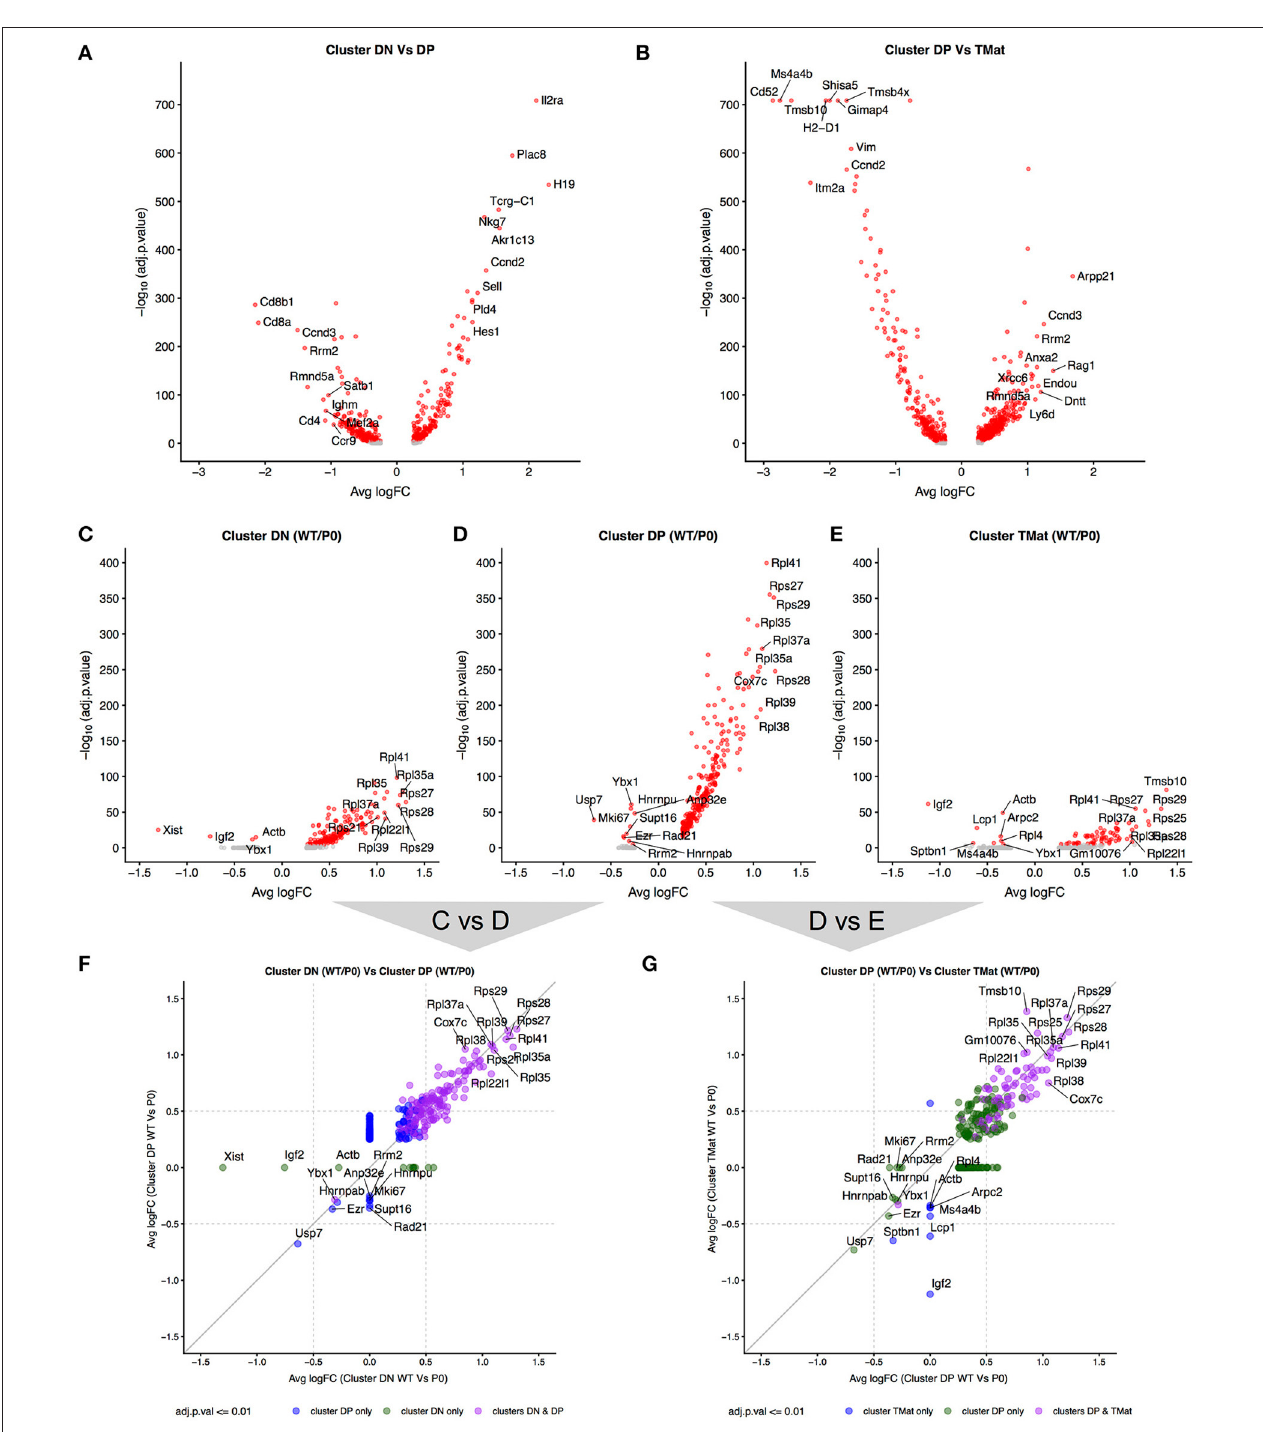
FIGURE 7 | Differential transcript levels between identified cell type clusters and within cluster WT/P 0 differences. (A,B) Volcano plots for differential transcript levels between the DN/DP and DP/T Mat cell type clusters. The top 10 genes are labeled for + /– average log fold change. (C–E) Within cluster, WT vs. P 0 cell transcript level comparisons revealing the ribosomal protein genes as the dominant set of genes especially evident within the DP cell type. (F,G) Comparison of the transcript level fold change between DN/DP and DP/T Mat cell type clusters shows a similar enrichment for the ribosomal protein genes (purple).